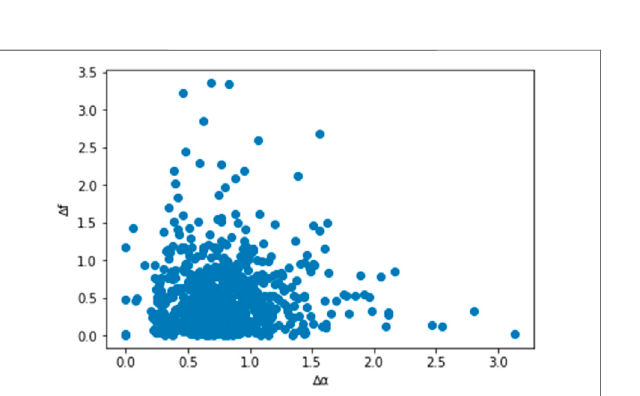
FIGURE 3 | Multifractal analysis of the return rate of China ’ s crude oil futures market under day granularity (taking 2018/05/24 as an example).